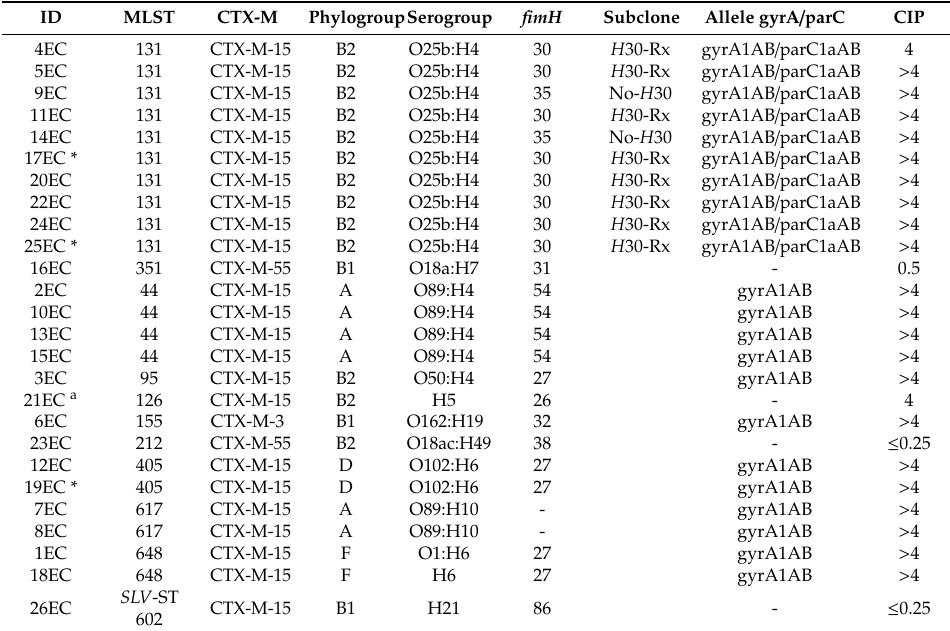
Table 2. Molecular data of CTX-M-harboring E. coli